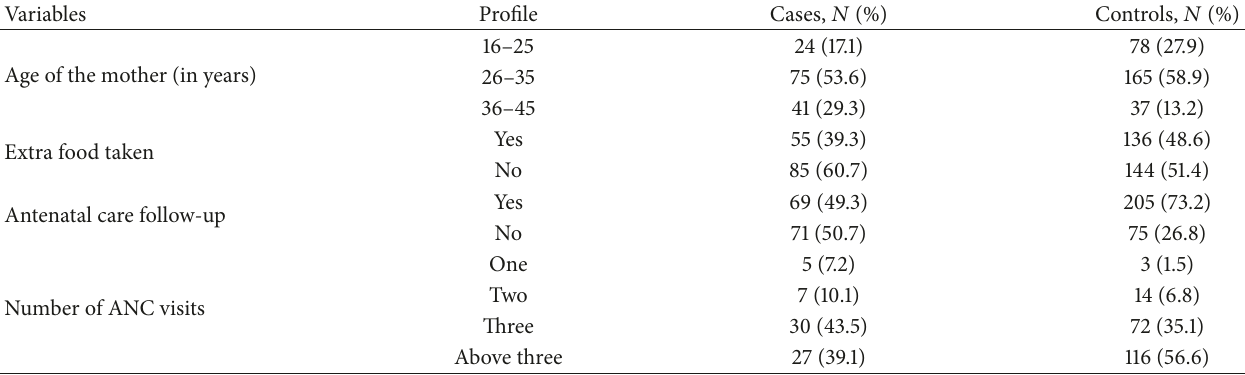
Table 3: Characteristics of the mothers of cases and controls from Dubti District, Afar Regional State, Northeast Ethiopia, January 2014 (cases: 𝑁 = 140 and controls: 𝑁 = 280